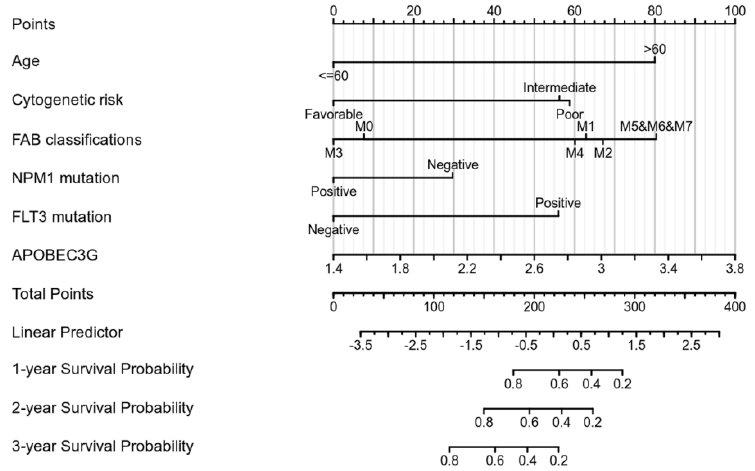
Figure 4. Nomogram for predicting the probability of 1-, 2-, and 3-year OS for AML.